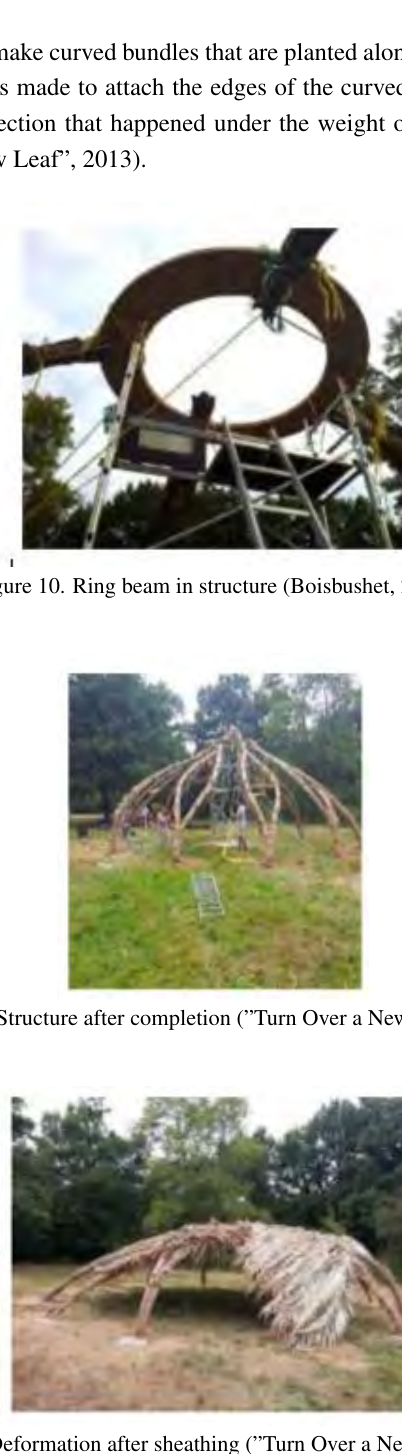
Figure 12. Deformation after sheathing (”Turn Over a New Leaf”,